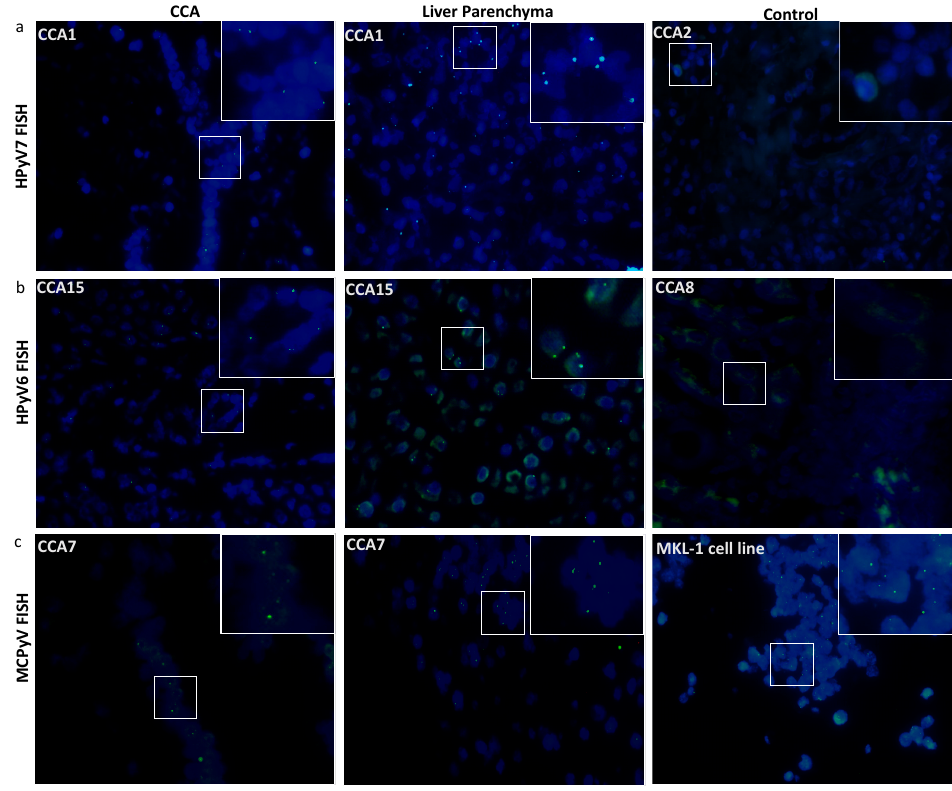
Figure 2. Detection of HPyV6, HPyV7, and MCPyV on the DNA in FFPE of CCA and non-neoplastic hepatocytes. Merged green (FITC) and blue (nuclei were counterstained with DAPI) show specific green signals. ( a ) Whole HPyV7 genome FISH probe performed on CCA1 tissue as a representative example of FISH for HPyV7 in CCA and non-neoplastic liver parenchyma cell while CCA2 tissue represents a negative case for HPyV7 DNA. ( b ) Whole HPyV6 genome FISH probe showed positive signals in both CCA and hepatocytes of CCA15, while the PCR-negative CCA8 case tissue revealed no signals. ( c ) Example of results of FISH specific nuclear of MCPyV in the nuclei of CCA epithelial, and the non-neoplastic hepatocytes. MKL-1 cell lines served as a positive control for the MCPyV probe. The images were taken at 630x magnification, a white square area was magnified 6x in the top right corner of each